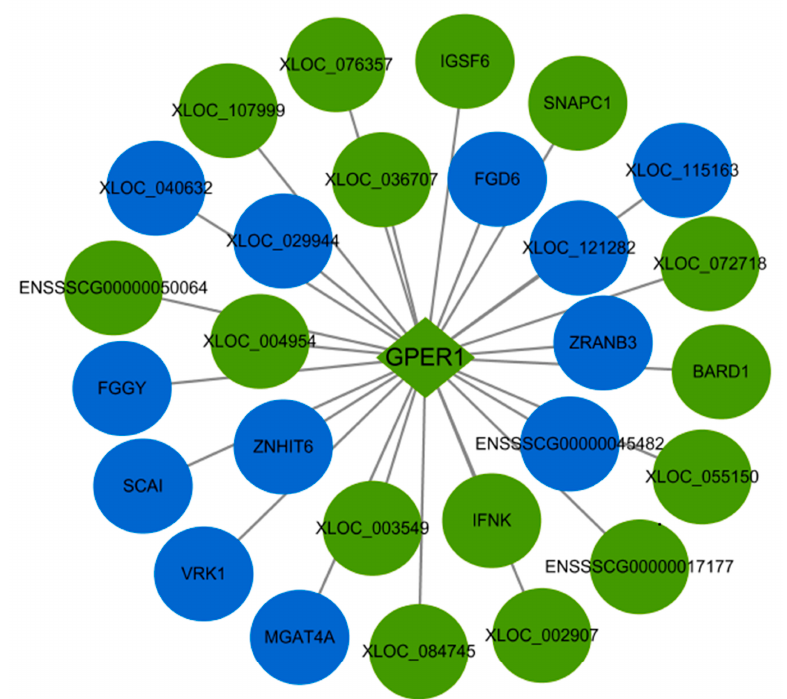
Figure 6. The interaction between the differentially expressed mRNAs and lncRNAs associated with GPER1 in the PTR2 cells infected with PRRSV. Blue means up-regulation, green means down-regu- lation.